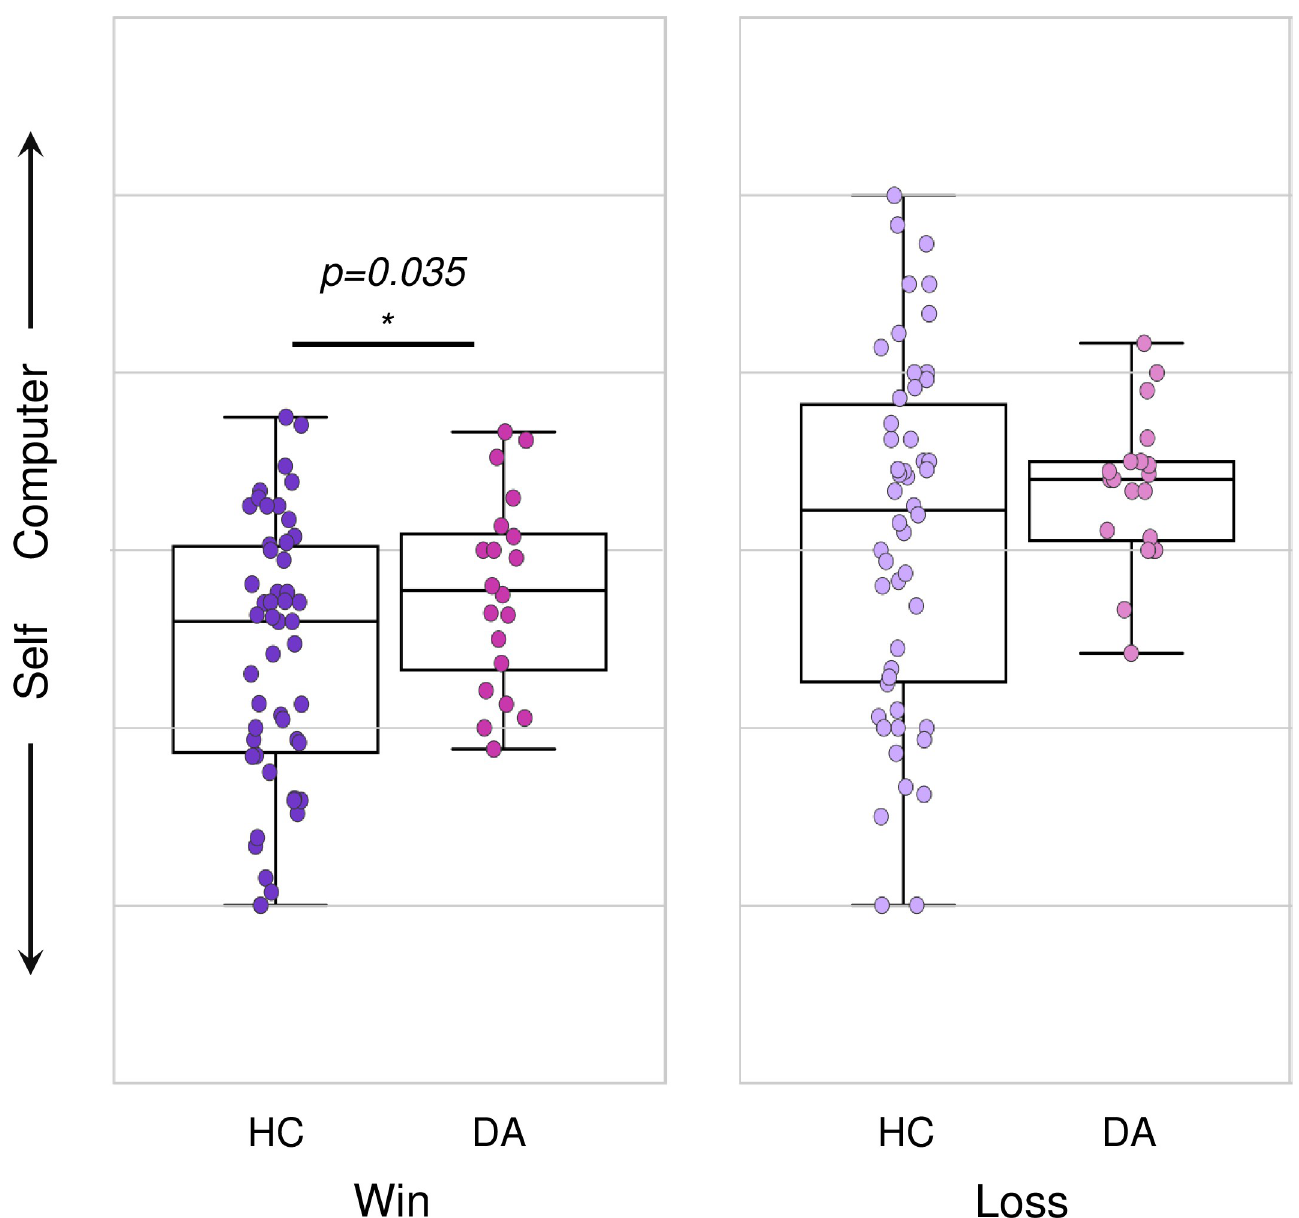
Fig 4. Lower negative feedback-dependent self-agency in depression and anxiety disorders. Agency ratings plotted following positive-win and negative-loss feedback during Ambiguous trials, plotted separately for healthy control subjects (N = 50) and subjects with depression and anxiety (DA) disorders (N = 20) (data is recapitulated from Fig